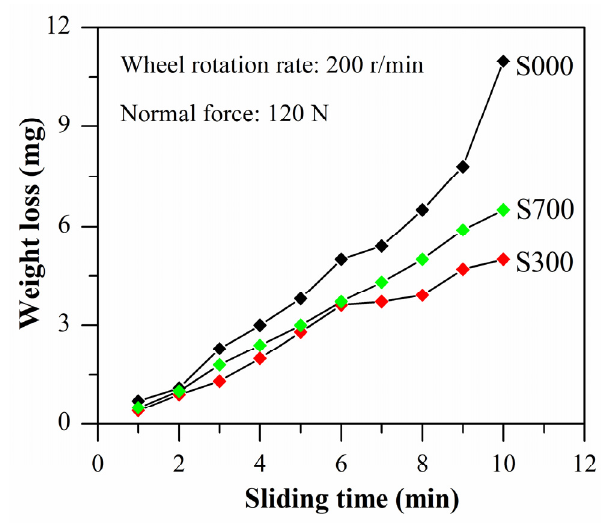
Figure 7. Weight loss of samples as a function of sliding time for base metal (S000) and FSP samples (S300 and S700).